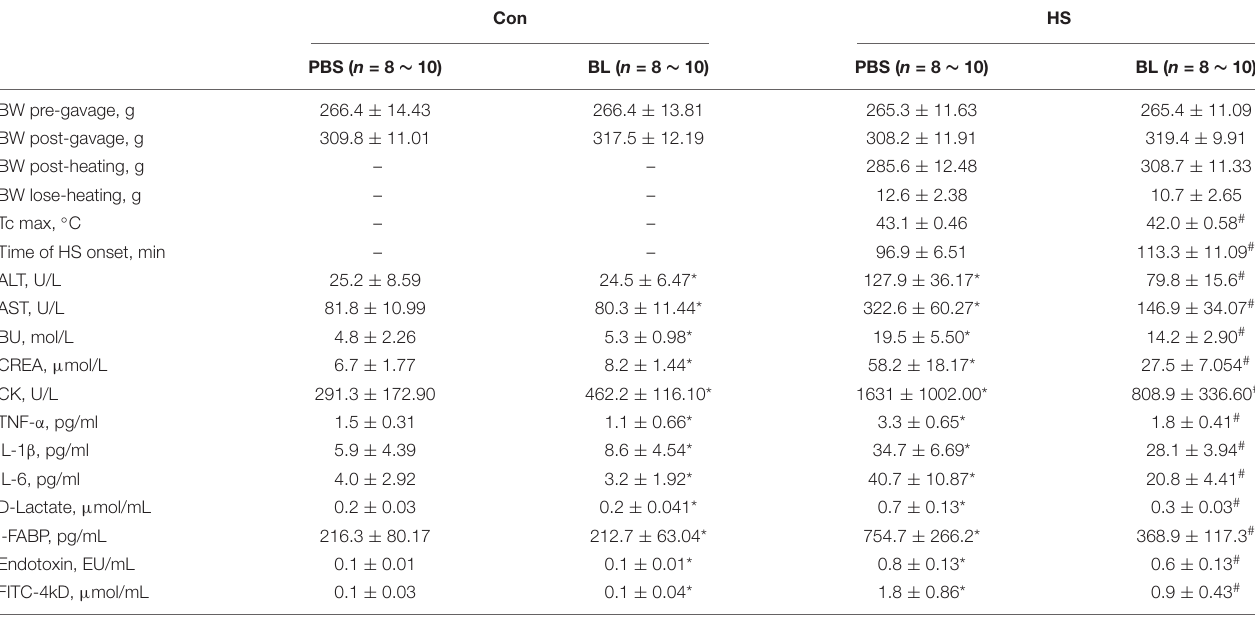
TABLE 1 | Experimental data and characteristics of rats subjected to BL and HS.